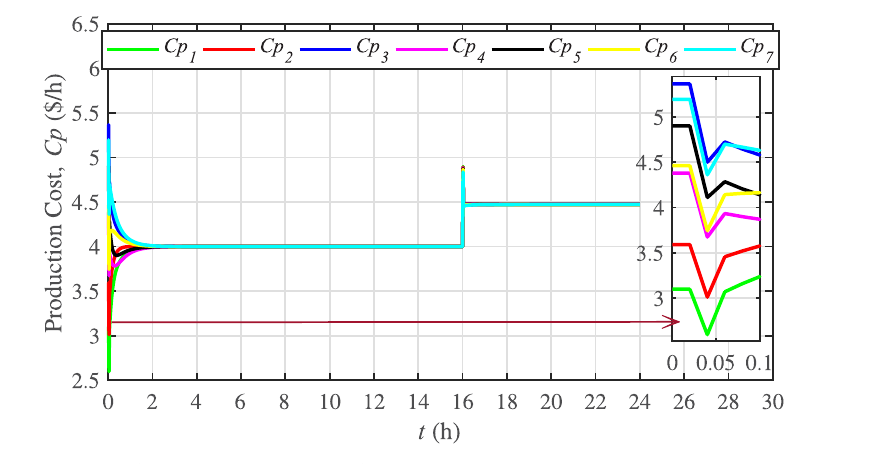
Fig 16. Production costs consensus under case 1.